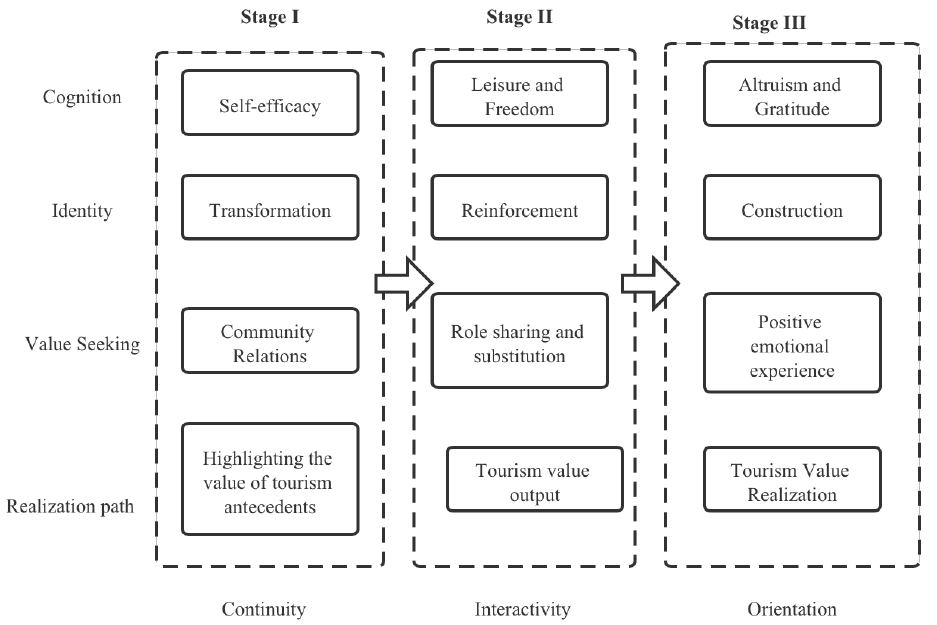
Figure 2. The intrinsic framework of the active aging stage tourism value narrative.